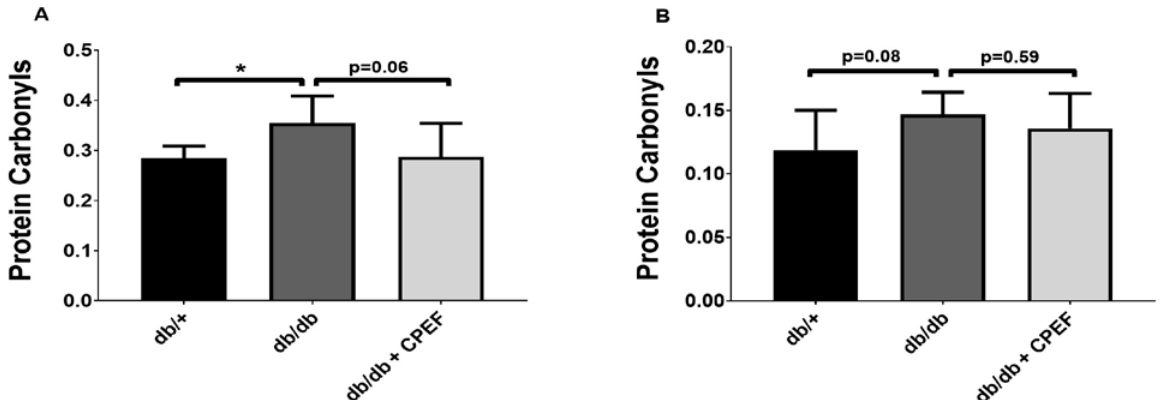
Figure 5. The effect of CPEF treatment on protein oxidation in the brown adipose tissue and liver of db/db mice. Mice were treated with the vehicle control or CPEF (351.5 mg/kg) daily for 28 days. Protein oxidation in the brown adipose tissue ( A ) and liver ( B ) was quantified using the protein carbonyl kit and normalised to protein content (nmol/mg protein). Data are represented as the mean ± SD ( n = 6–8). Statistical significance between the groups is denoted as * p < 0.05 compared to the db/db control